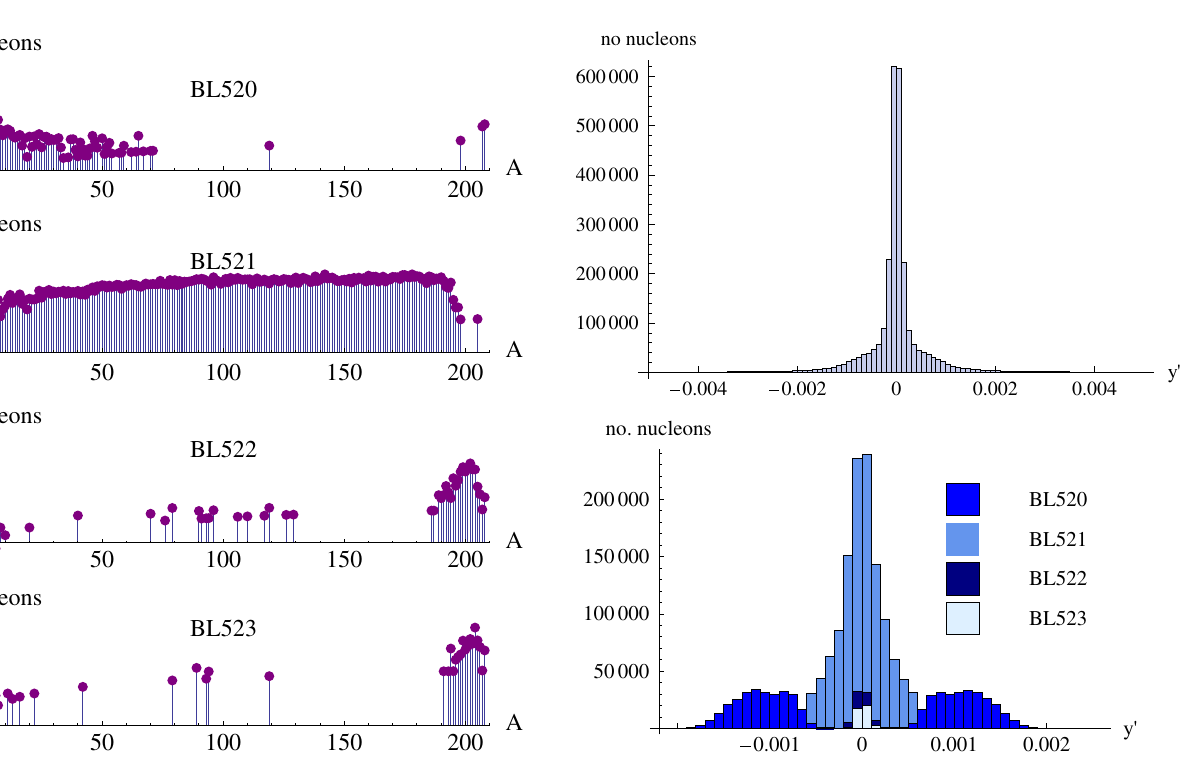
FIG. 16. (Color) The simulated distribution from the FLUKA full method of y 0 of all ion fragments coming out of the collimator (top) and of the ions lost within a 15 m interval upstream of each BLM (bottom). The heights of the bars show the number of nucleons belonging to ions within a certain interval.